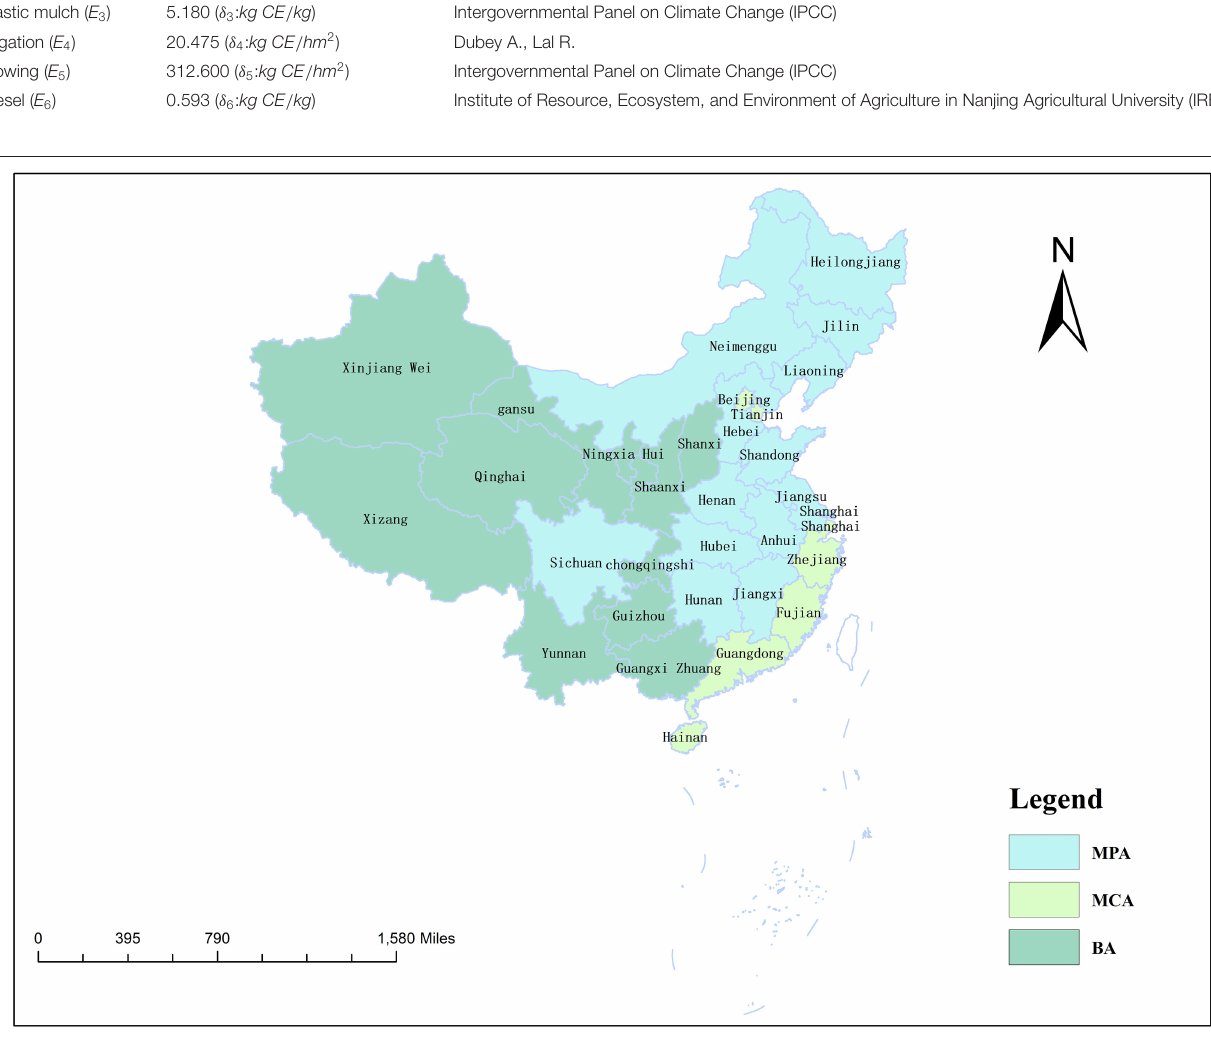
FIGURE 1 | Distribution of food production areas in